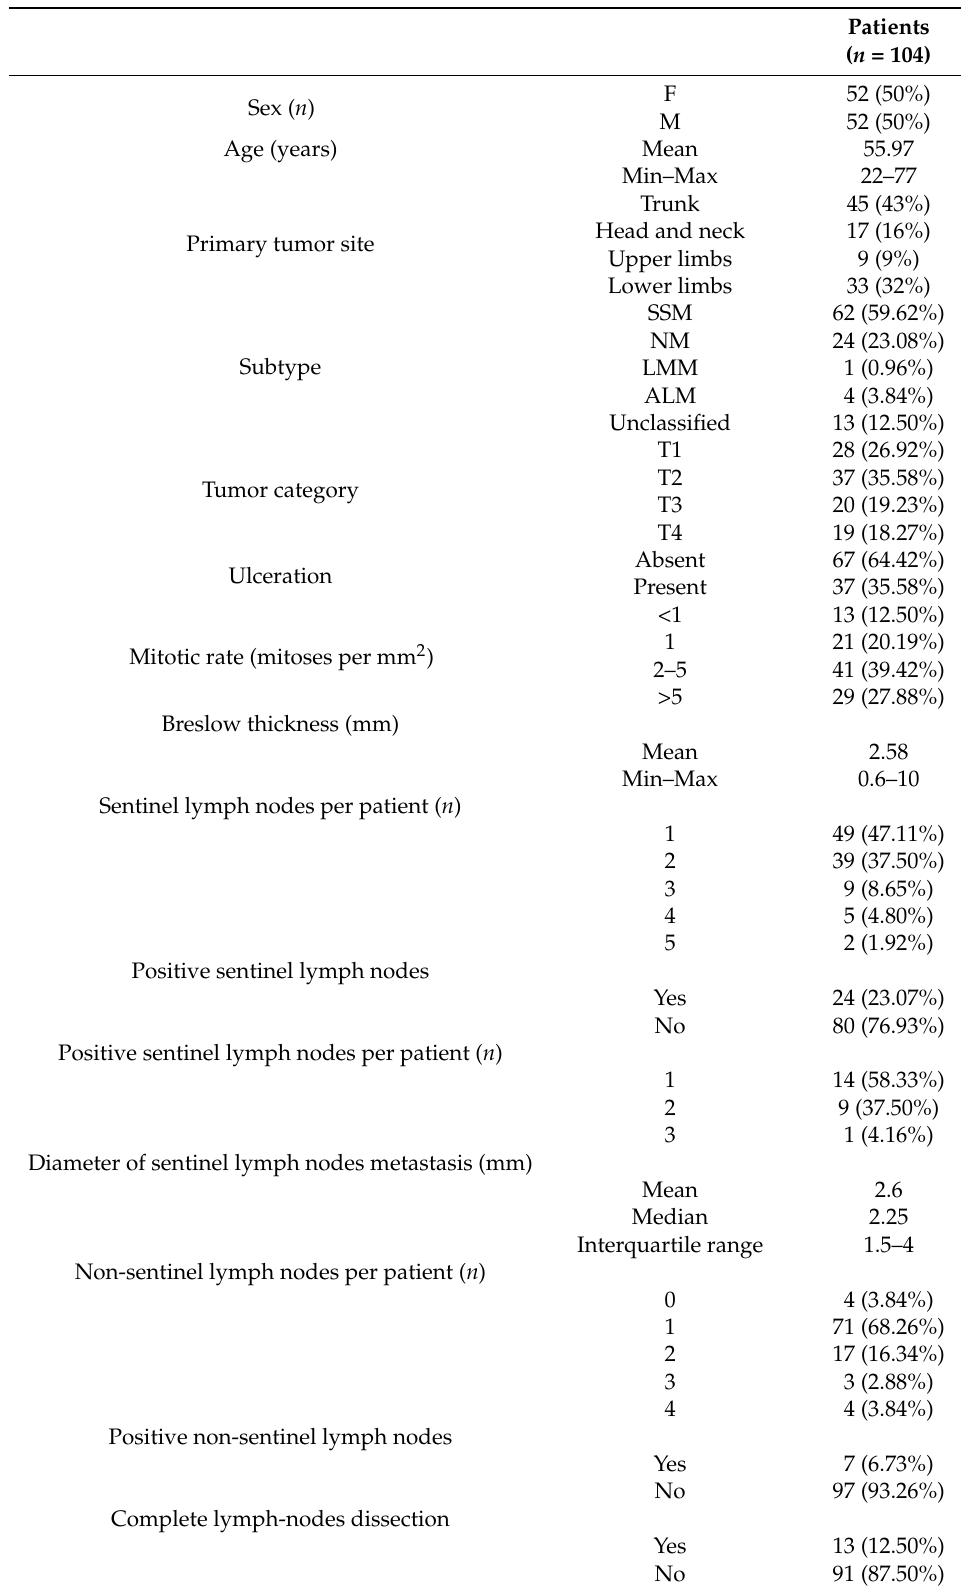
Table 1. Demographics and clinical characteristics of patients eligible for SNLB